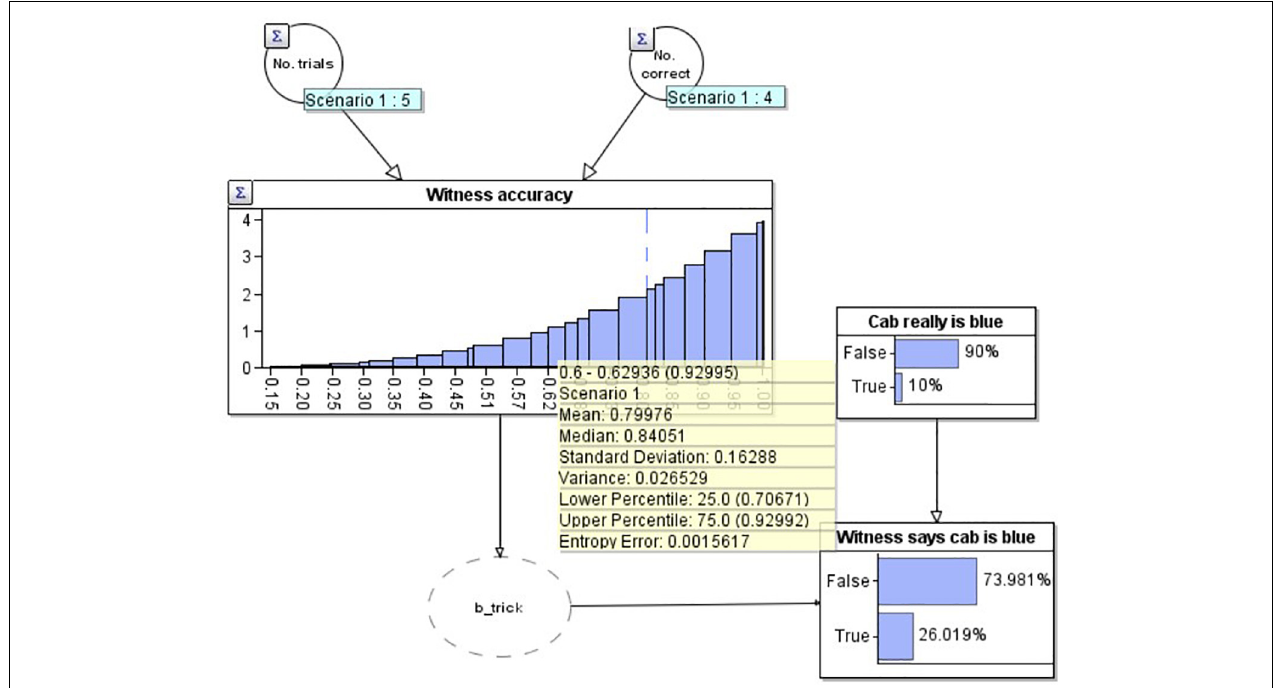
FIGURE 2 | A Bayesian network depicting the modified taxi cab problem prior to the witness reporting the cab is blue.